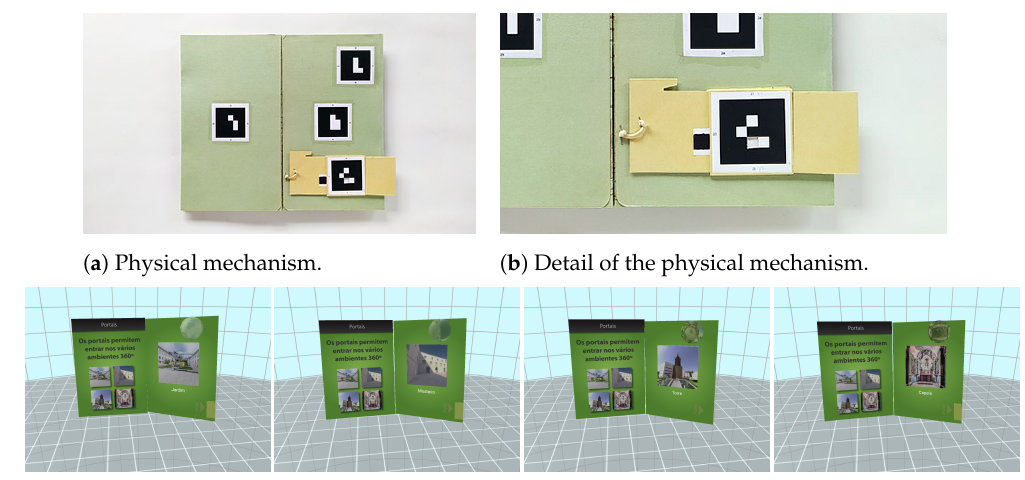
Figure 6. Content selection through the tangible